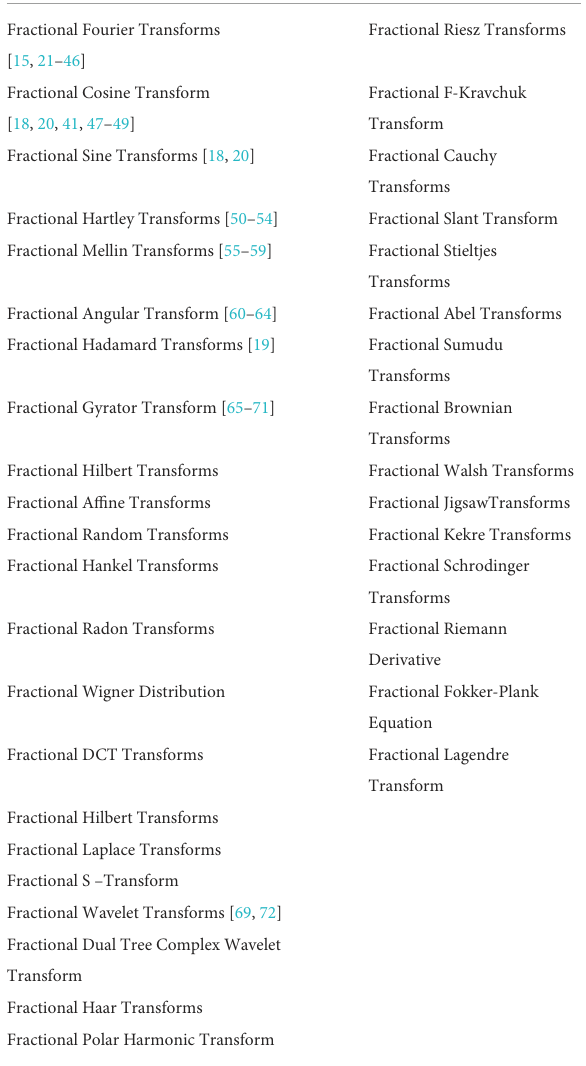
TABLE 1 Various fractional integral